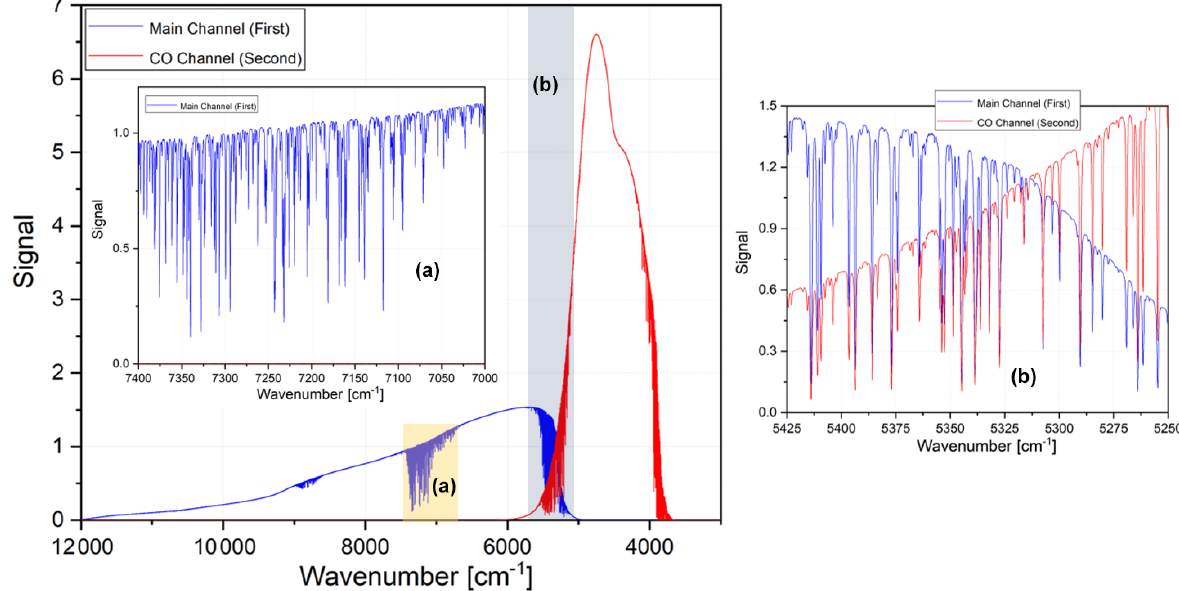
Figure 4. Typical spectra for both channels, obtained with the COCCON reference instrument SN37 on 19 March 2021. The highlighted regions (a) and (b) are the spectral windows used for the ILS retrievals.